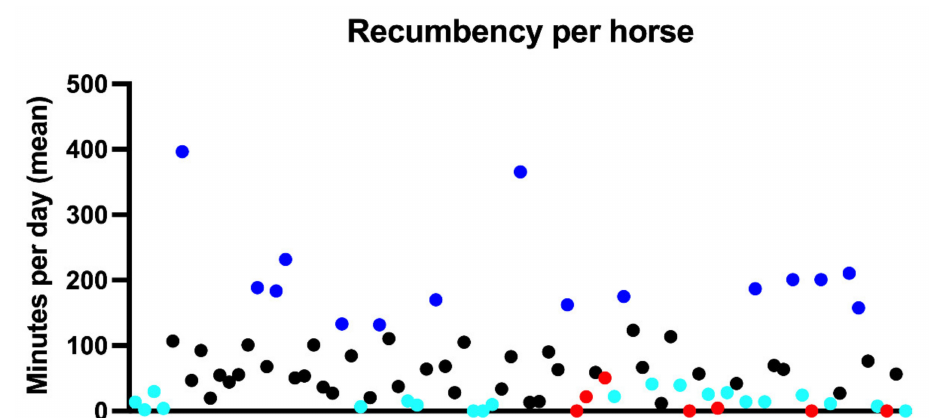
Figure 4. Recumbency time budget (mean %) per horse (horses are distributed alphabetically along the x-axis). Horses with established REM deficit are highlighted in red, turquoise indicates horses with less than 30 min sleep per day throughout the study period, and horses that lay down more than average are marked in blue.